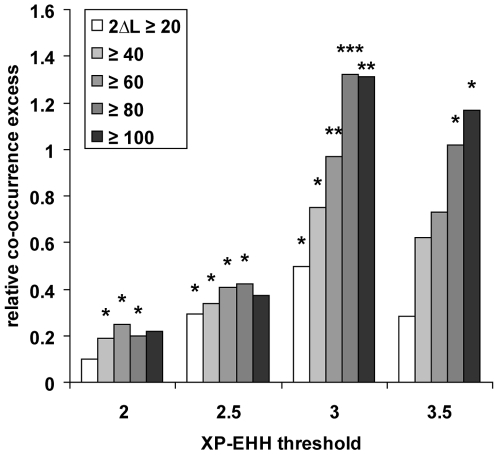
Co-occurrence between PAML branch-site test 2 positive selection
candidates in non-human branches and XP-EHH worldwide human populations
selective sweep candidates.The co-occurrence test was applied using increasing 2ΔL values
(twice the log-likelihood ratio) to assign positive selection candidate
genes in chimpanzee, orangutan, macaque and human-chimpanzee branches of
a primate phylogenetic tree on the one hand (see Methods; Figure S5, group 1), and increasing
XP-EHH values at genomic centres of genes tested in seven human
populations [5] (Figure
S5, group 2) on the other hand. The histogram represents the
relative co-occurrence excess (observed/expected – 1) for
combinations of XP-EHH threshold values increasing from 2 to 3.5 and
branch-site test 2 2ΔL thresholds from 20 to 100 (Methods). *: co-occurrence
test P≤0.05. **:
P≤0.01. ***:
P≤0.001.